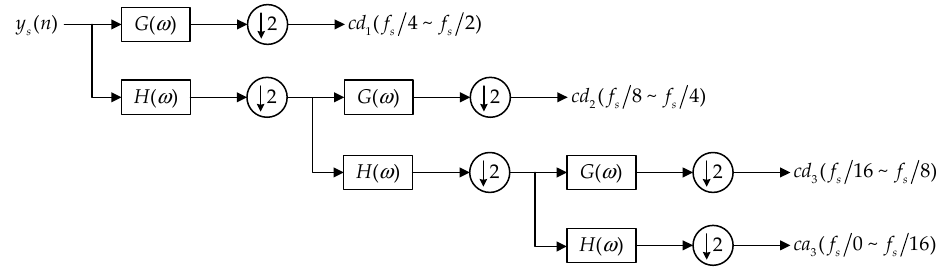
Figure 3. Scheme of wavelet decomposition.